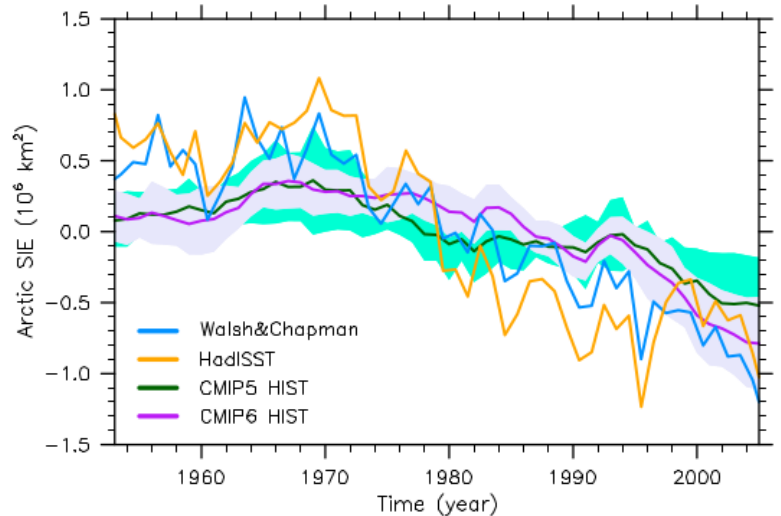
Figure 1. Annual mean Arctic sea ice extents (relative to the 1953–2005 average) from Walsh and Chapman (blue) and HadISST (orange) data and CMIP5 (MMM, green; inter-model spread, light green) and CMIP6 (MMM, purple; inter-model spread, light purple) historical simulations during 1953–2005. Sea ice extent is calculated as the integral sum of the areas of all grid cells with a sea ice concentration of at least 15%. The inter-model spread is calculated as one standard deviation among the ensemble means of individual models.